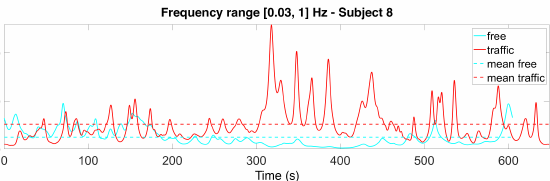
Figure 6. Signals obtained as a sum of the squared absolute values of the CWT coefficients in the selected frequency range for Subject 8 (in both